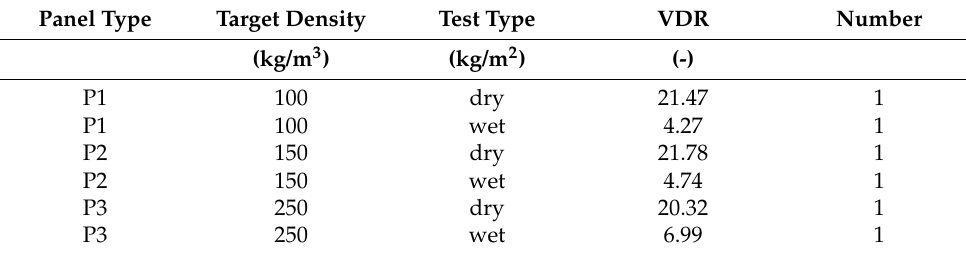
Table 7. Vapor diffusion resistance of resin-bound peat moss